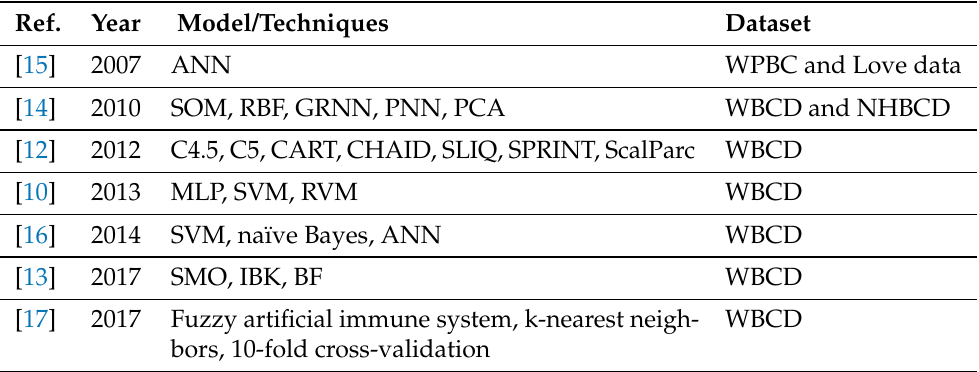
Table 1. Summary of the discussed research works.